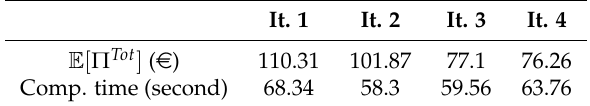
Table 2. Model solution report for a fleet of 1000 EVs; χ = 0.01, It.: itertaion.